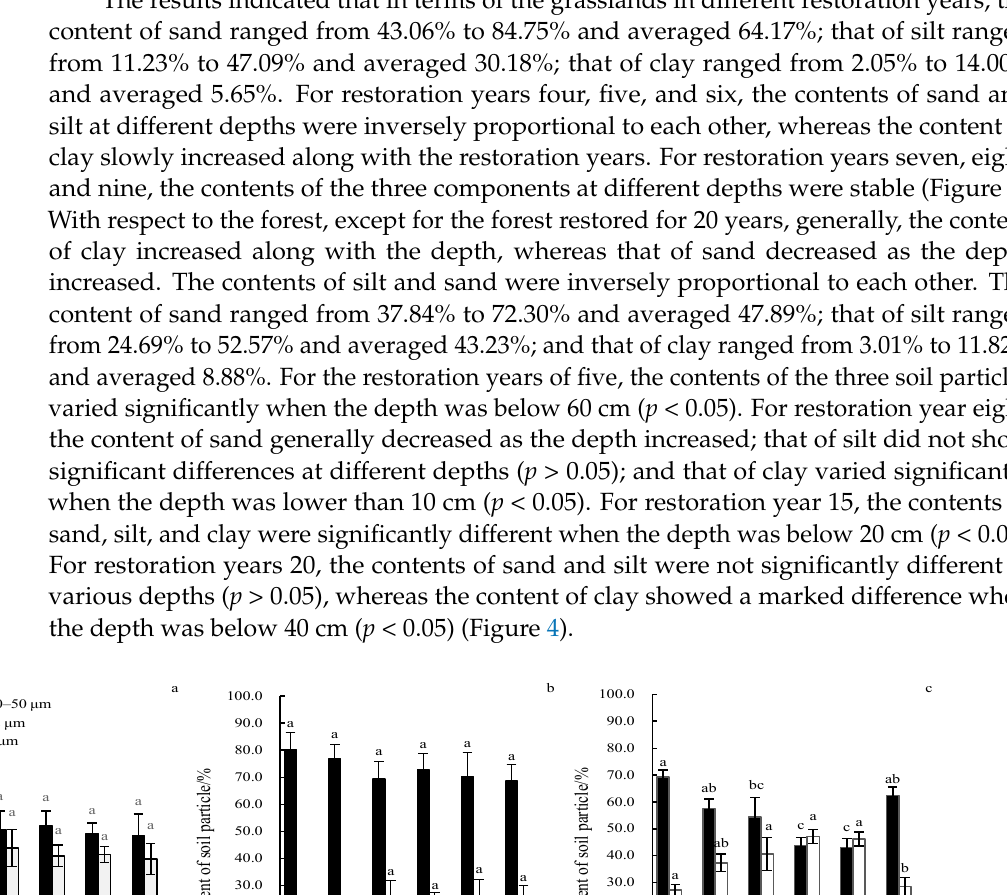
Figure 4. Distribution of soil particles in woodlands in different restoration years (( a – d ) in the fig- ure represent restoration 5a, 8a, 15a, and 20a, respectively, the same as below). Notes: The lower- case letters in the figures represent significant differences in the same component at different depths ( p < 0.05).